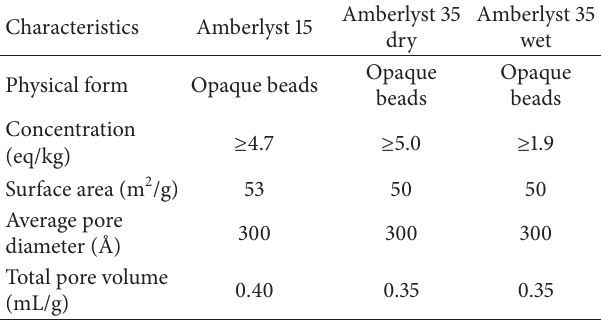
Table 1: Characteristics of catalysts of catalysts used in this study.